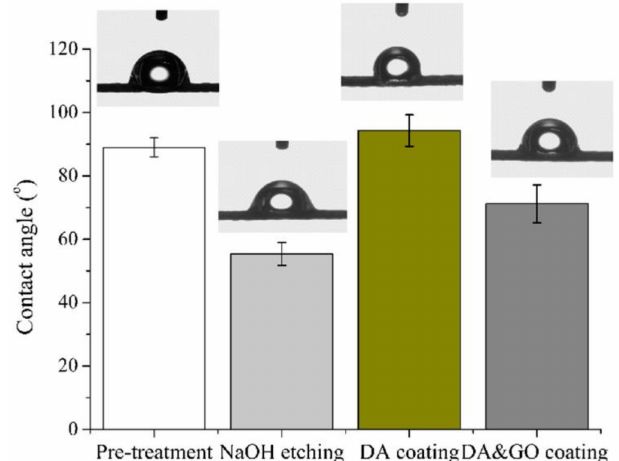
Figure 8. Water contact angle of the multifilament surgical sutures with di ff erent